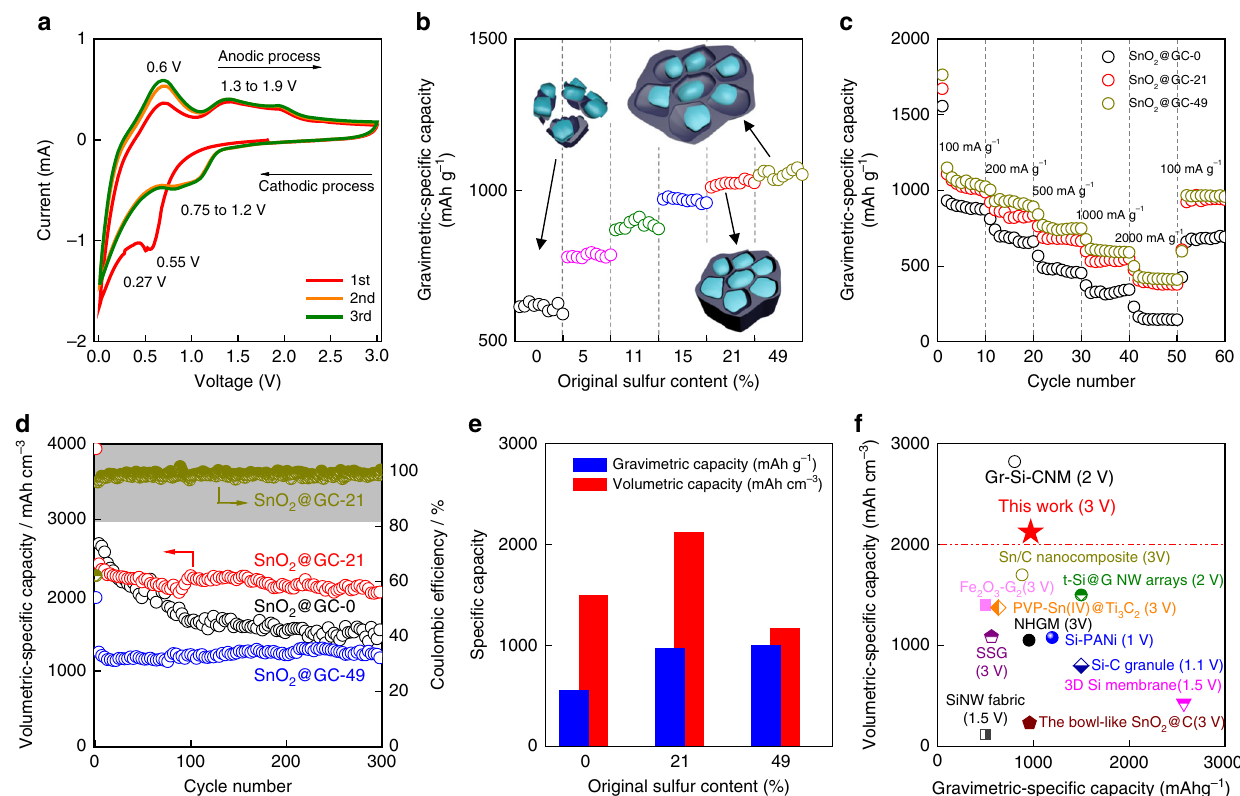
Fig. 4 Electrochemical characterization of SnO 2 @GCs. a Representative cyclic voltammetry curves (CVs) of SnO 2 @GC-21 at a scan rate of 0.5 mV s – 1 . b The gradient electrochemical performance change of SnO 2 @GCs based on the different original sulfur contents when the gravimetric capacity became stable at around the 130 th – 140 th cycles (100 mA g – 1 ). The overall cycling performance of SnO 2 @GCs can be observed in Supplementary Fig. 17. c Rate performance of SnO 2 @GCs. d Cycling performance of SnO 2 @GC-0, 21 and 49 at a current density of 100 mA g – 1 . e , f Comparison of the volumetric and gravimetric speci fi c capacities of SnO 2 @GC-21 with the referenced cases (based on the total active materials). e Comparison with SnO 2 @GC-0 and SnO 2 @GC-49. f Comparison with other reported anode materials (based on the total active materials), such as t-Si@G NW arrays 5 , Fe 2 O 3 -G 2 6 , PVP-Sn (IV)@Ti 2 C 7 , Sn/C nanocomposite 8 , SSG 9 , Si-C granule 10 , Si-PANi 13 , NHGM 15 , SiNW fabric 22 , 3D Si membrane 23 and the bowl-like SnO 2 @C 27 , and Gr-Si- CNM 45 , with a voltage it charged to (see details in Supplementary Table